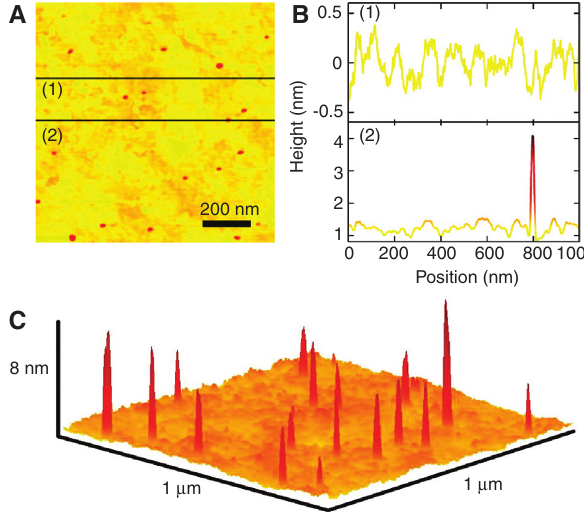
Figure 3: Ultrasmooth gold layers obtained by stripping from mica substrates. (A) CdSe quantum dots on a gold layer; (B) height profiles of a flat gold layer and a layer with a quantum dot; (C) three-dimensional AFM image of quantum dots on the gold layer. Reproduced with permission from [55].